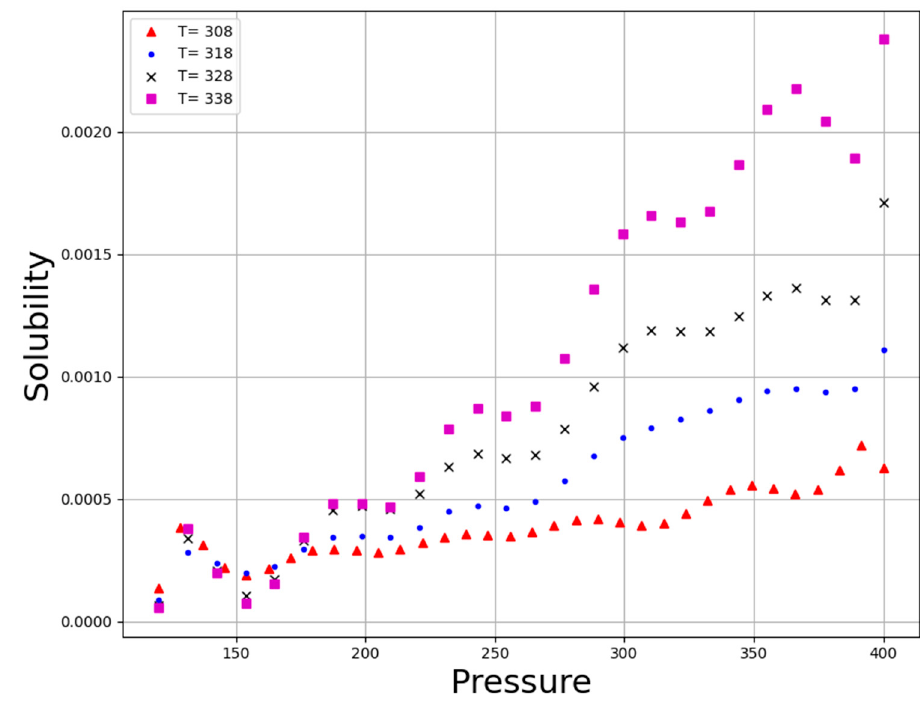
Figure 6. Tendency of P.